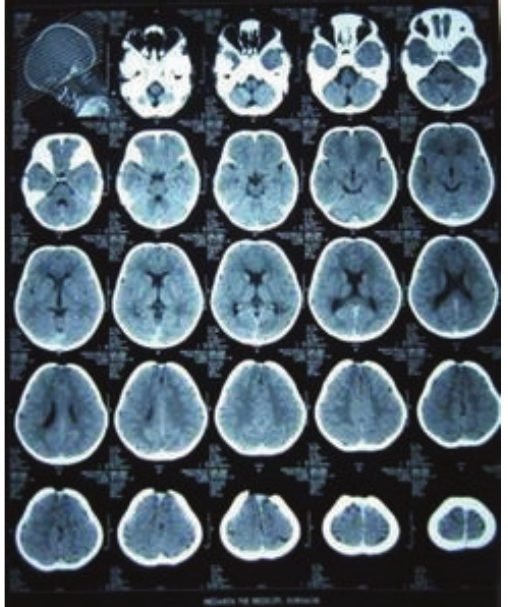
Figure 5: CT scan skull.